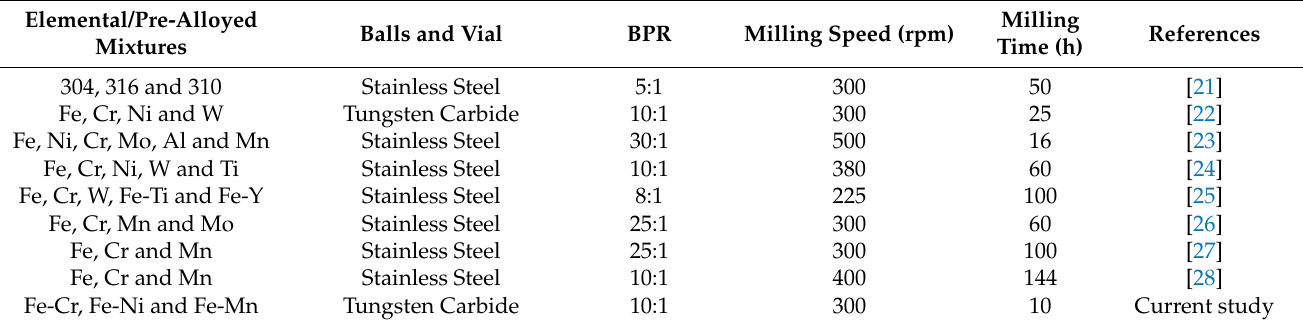
Table 2. Evolution of various austenitic grade stainless steels from different starting powders through MA.